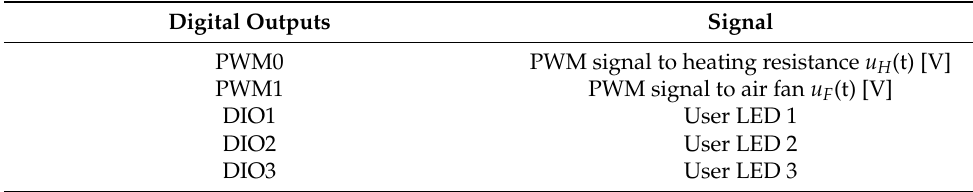
Table 5. Deusto Heater Experimental Setup—Digital output signals connected to the control hardware through the I/O